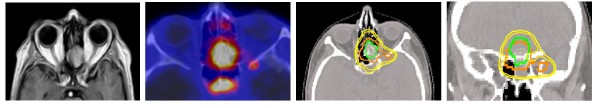
Recurrence of olfactory's meningioma (MRI left). [68Ga]-DOTATOC-PET/CT image fusion with small distant lesion at the left dorsal orbital bone and physiological tracer uptake of the pituitary gland. Dose distribution (right) with inclusion of the small distant lesion and enclosing 90% PTV isoline.